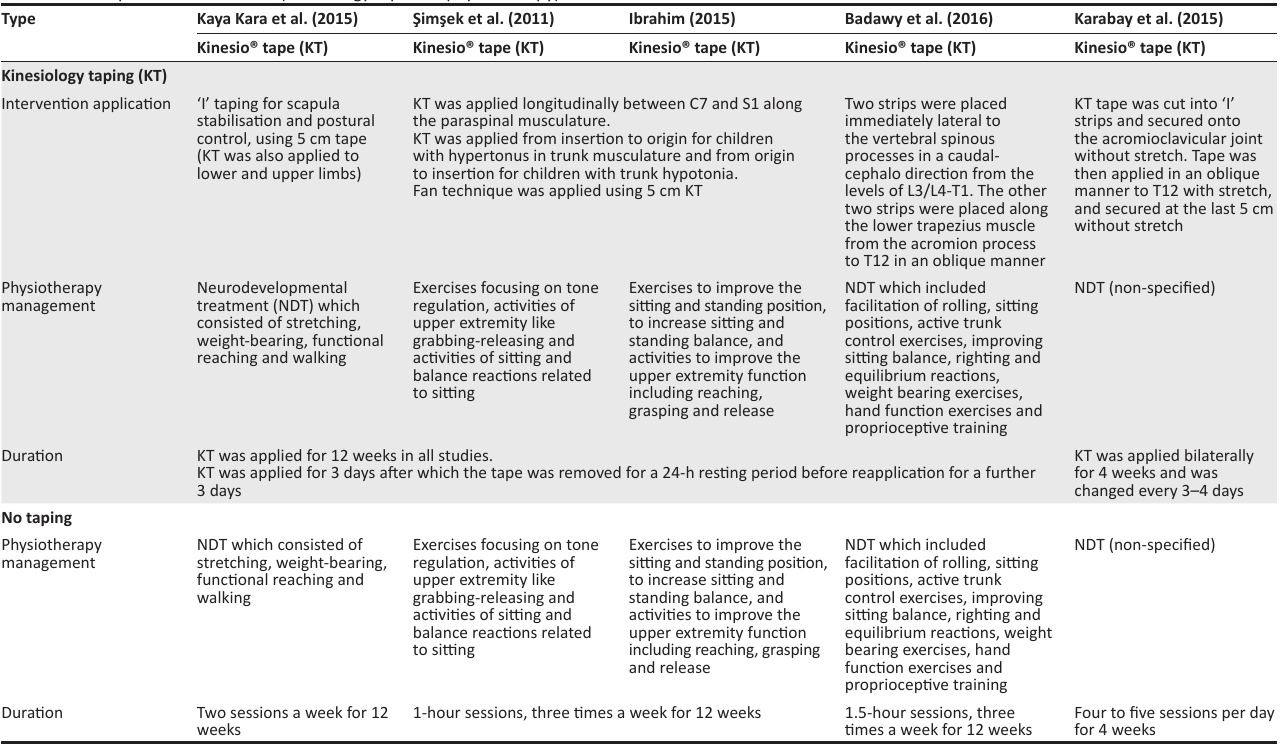
TABLE 3: Description of intervention (kinesiology tape and physiotherapy).